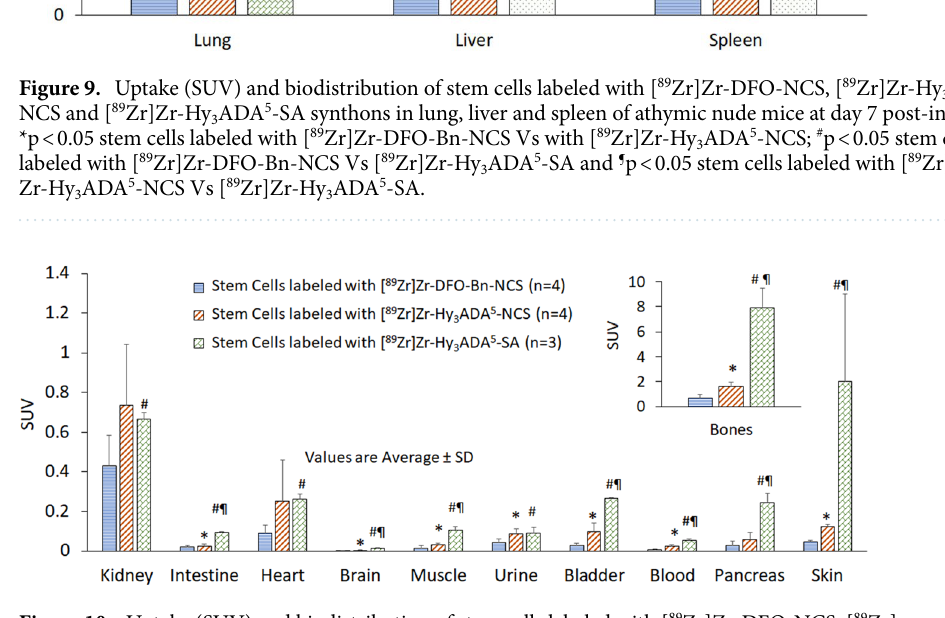
Figure 10. Uptake (SUV) and biodistribution of stem cells labeled with [ 89 Zr]Zr-DFO-NCS, [ 89 Zr] Zr-Hy 3 ADA 5 -NCS and [ 89 Zr]Zr-Hy 3 ADA 5 -SA synthons in athymic nude mice at day 7 post-injection. *p < 0.05 stem cells labeled with [ 89 Zr]Zr-DFO-Bn-NCS Vs [ 89 Zr]Zr-Hy 3 ADA 5 -NCS; # p < 0.05 stem cells labeled with [ 89 Zr]Zr-DFO-Bn-NCS Vs [ 89 Zr]Zr-Hy 3 ADA 5 -SA and ¶ p < 0.05 stem cells labeled with [ 89 Zr]Zr-Hy 3 ADA 5 -NCS Vs [ 89 Zr]Zr-Hy 3 ADA 5